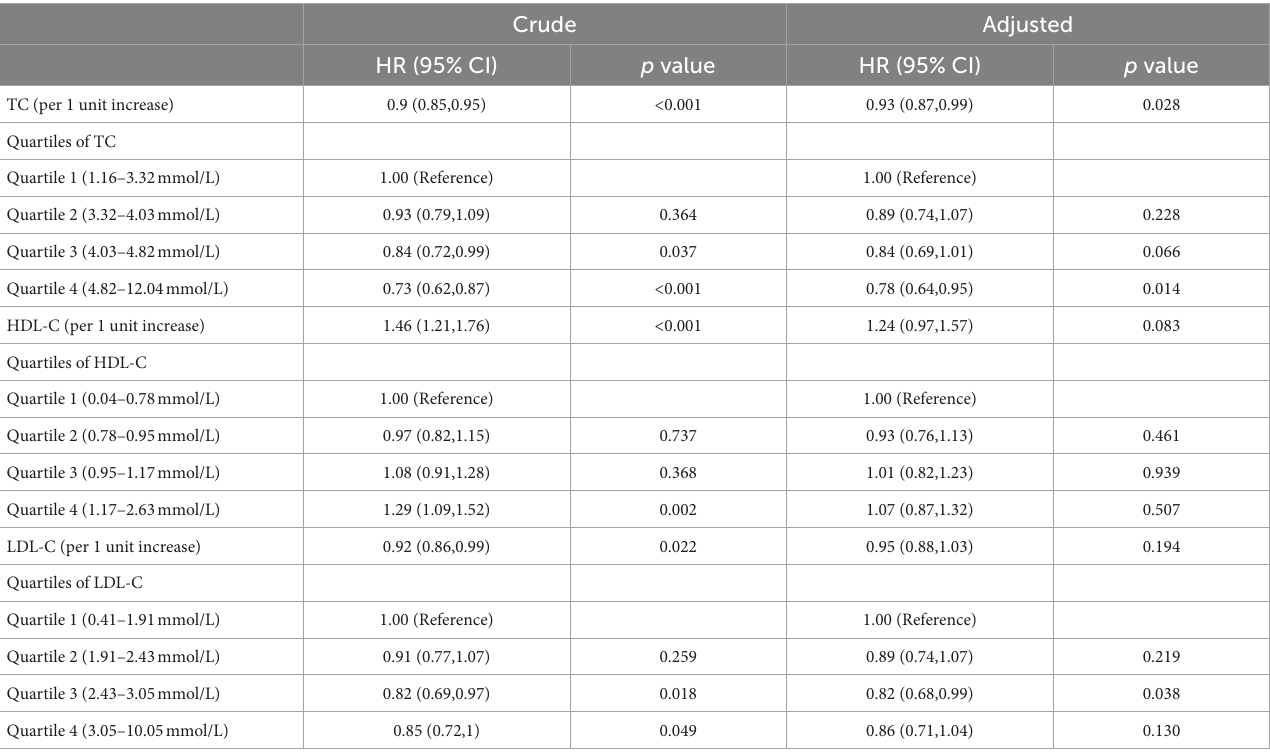
TABLE 2 Hazard ratios for all-cause mortality associated with TC, HDL-C, and LDL-C.